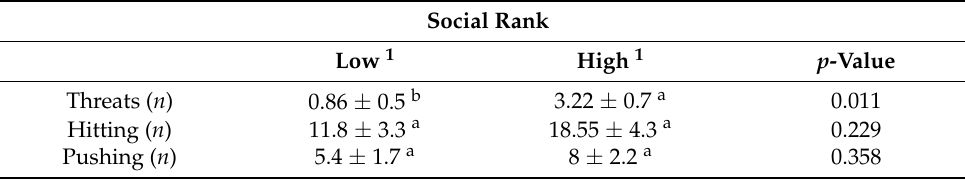
Table 1. Least square means ± standard error for the male-to-male interaction at the onset of the experimental period (July, reproductive arrest), considering threats, hitting, and pushing according to either low ( n = 15) or high ( n = 9) social rank in Dorper rams ( n = 24) in northern Mexico (25 ◦